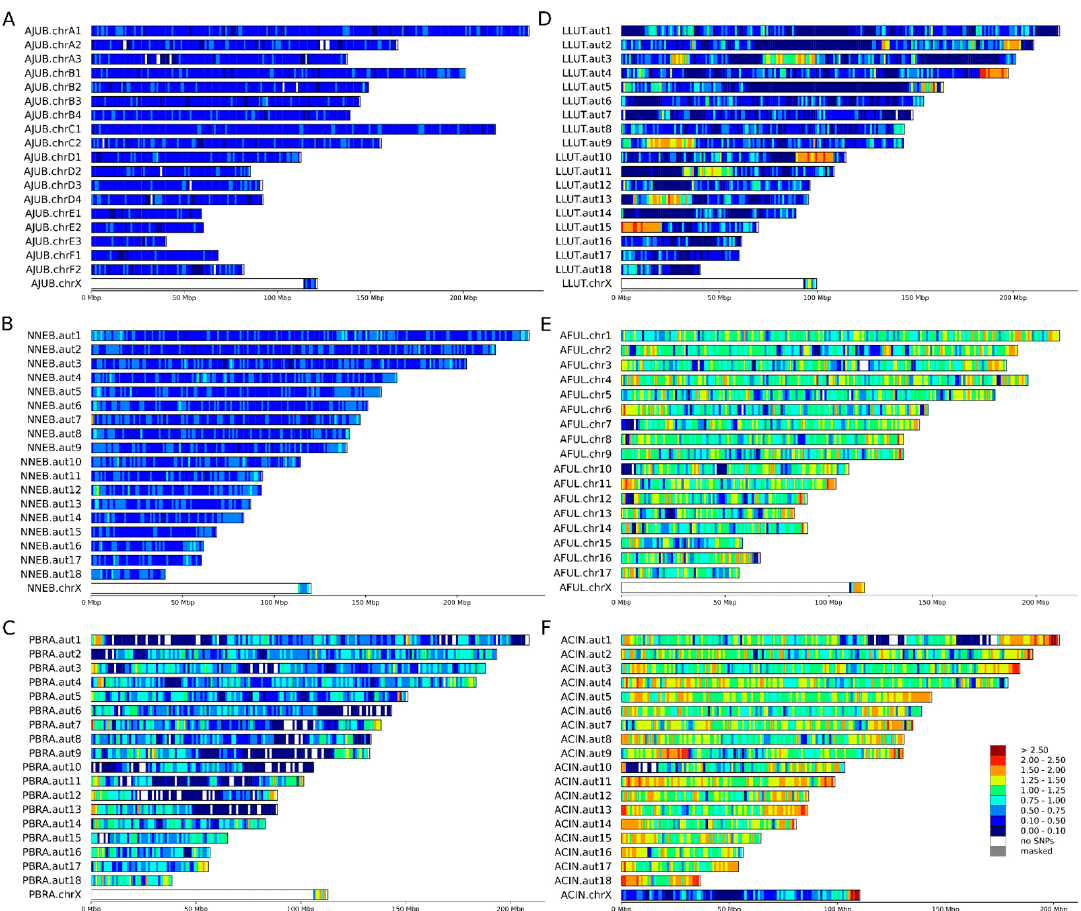
Figure 1. Heatmaps of heterozygous SNP densities for analyzed species based on chromosome-level assemblies for single individuals of six species. Heterozygous SNPs were counted in 1 Mbp windows and scaled to SNP/kbp. ( A ) male cheetah ( Acinonyx jubatus ), ( B ) male clouded leopard ( Neofelis nebulosa ), ( C ) male giant otter ( Pteronura brasiliensis ), ( D ) male Eurasian river otter ( Lutra lutra) , ( E ) male red panda ( Ailurus fulgens ), ( F ) female Asian small-clawed otter ( Aonyx cinereus ). Table 3. Counts of heterozygous single nucleotide polymorphisms (SNPs), windows and counts, median, and mean heterozygosity in windows of 100 kbp and 1 Mbp for draft and chromosome-level assemblies (Chr.) assemblies of the analyzed genomes. Two species with the lowest window counts are in italic. Bold indicates cases where comparison of mean heterozygosity in windows of 100 kbp and 1 Mbp showed statistically significant difference for significance, level 0.01. p -Value #* Het. SNPs, Median, Het Mean, Het #*Windows Millions Window SNPs/kbp SNPs/kbp (Draft vs. Species Size